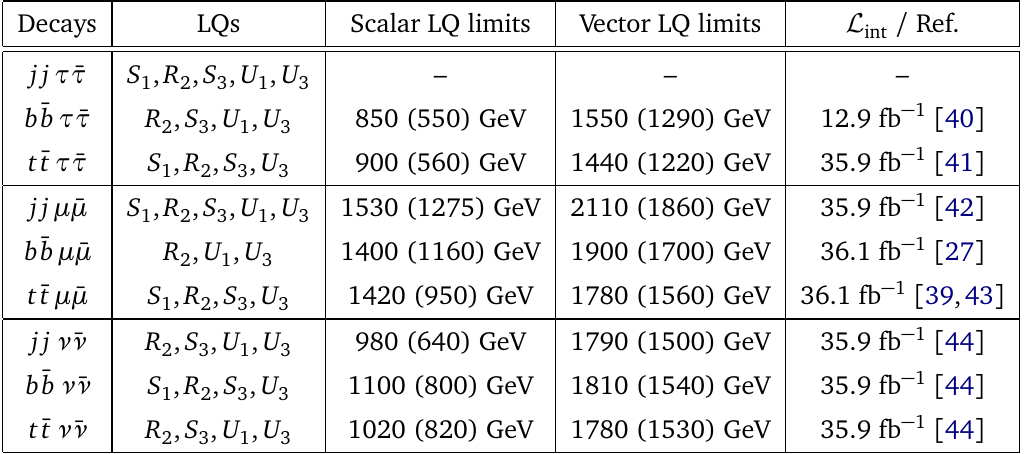
Table 2: Summary of the current limits from LQ pair production searches at the LHC. In the first column we give the searched final states and in the second column the LQs for which this search is relevant. In the next two columns we present the current limits on the mass for scalar and vector LQs, respectively, for β = 1 ( β = 0.5 ) . In the last column we display the value of the LHC luminosity for each search along